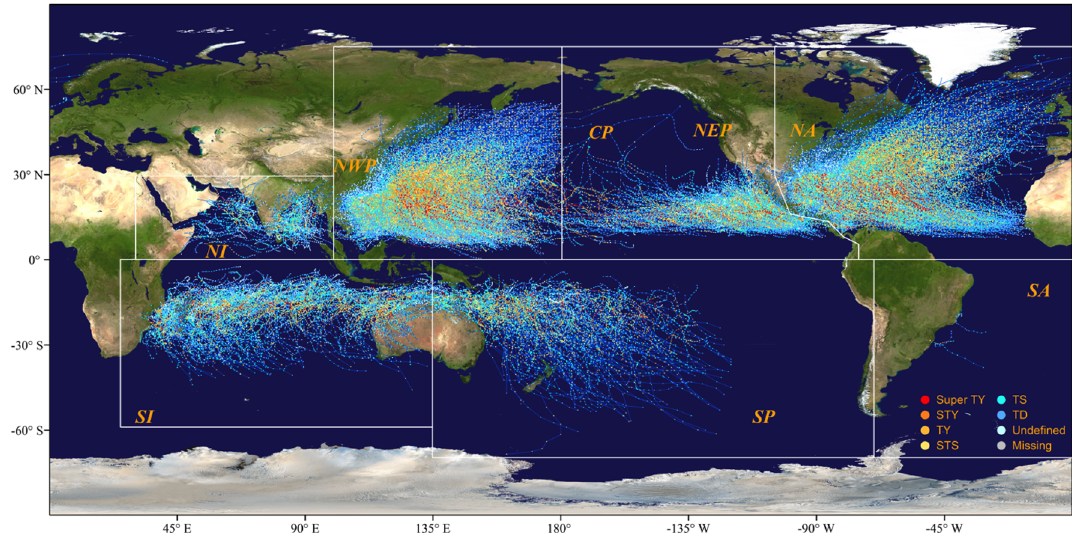
Fig. 1 Global tropical cyclone tracks by ocean basin based on historical TC best track datasets. Note Ocean basins are: NWP Northwest Pacific, NEP Northeast Pacific, CP Central Pacific, NA North Atlantic, SA South Atlantic, NI North Indian, SP South Pacific